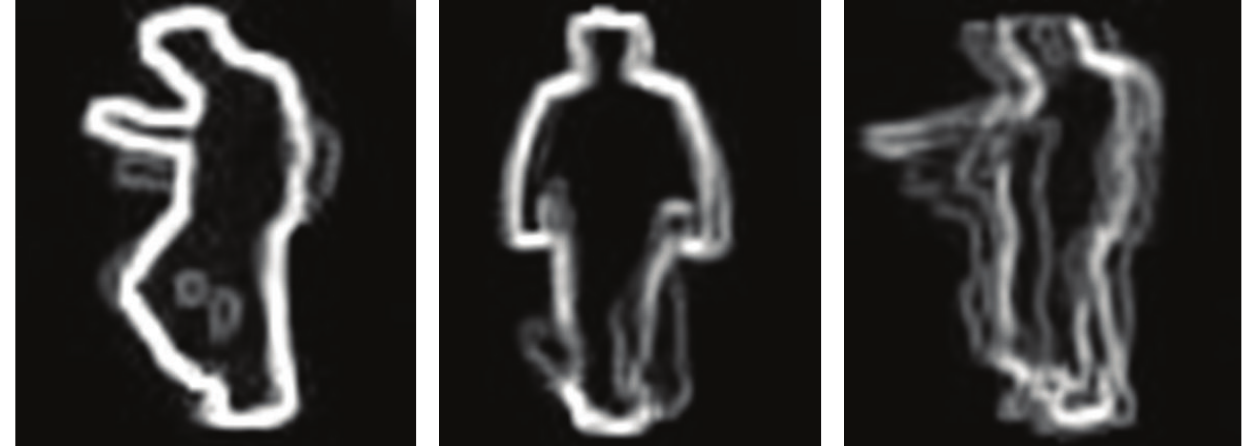
Figure 5: Different intensity values features applied over exercise, kicking, and cleaning activities.